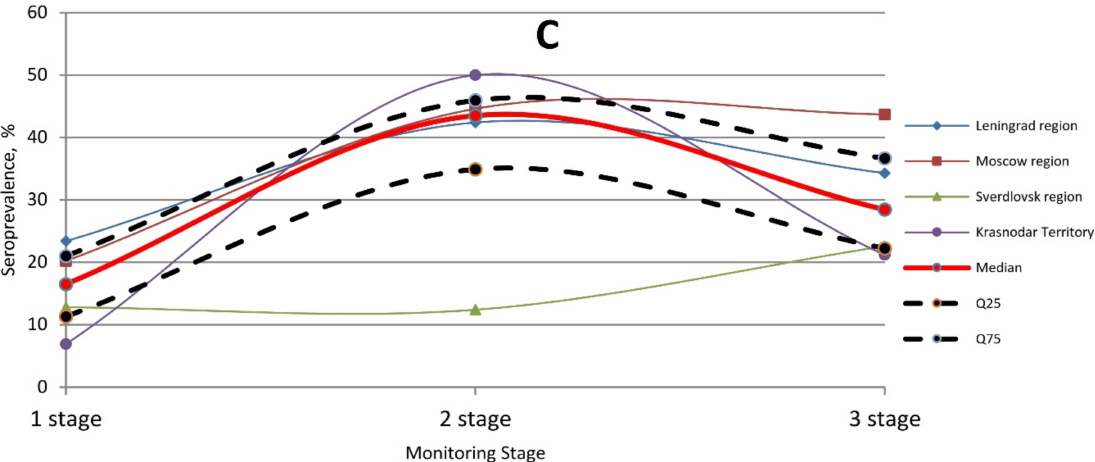
Figure 5. Three curve types for the formation of population immunity to SARS-CoV-2 in different Russian regions. ( A ). The most common dynamics of formation of specific SARS-CoV-2 immunity. In the process of population contact with coronavirus, the proportion of seropositive individuals in the population increases, reaching a maximum by the 3rd phase. ( B ). Less frequent curve showing a slower process of seropositivity formation. By the 2nd phase, the percent of the Nc Ab seropositivity volunteers decreased. The maximum Ab level is formed only by the 3rd phase. ( C ). The rarest paradoxical reaction in which percent seropositive increases between phases 1 and 2, and then decreases markedly. Immunity formation dynamics in the surveyed regions are shown by thin colored lines. The median is represented by a thicker red curve. The boundaries of the interquartile range Q25—Q75 are plotted as bold, dashed